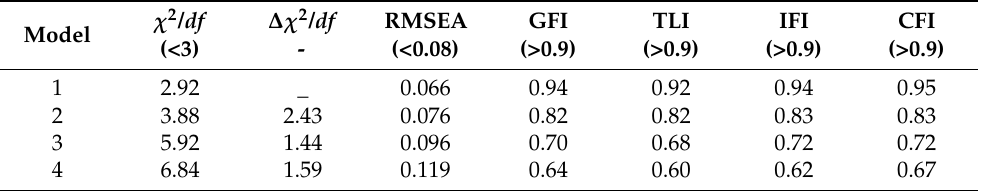
Table 4. Model fitness.